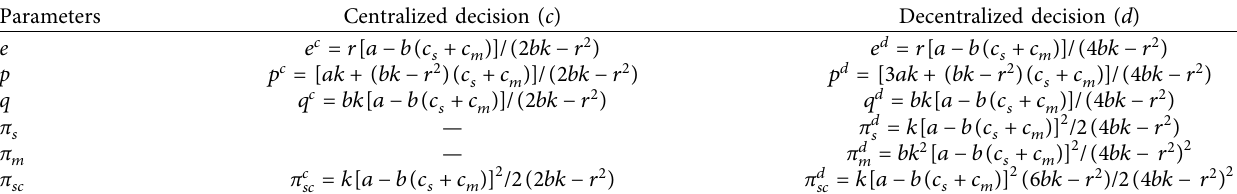
Table 2: Supply chain equilibrium results in different decision situations. Parameters Centralized decision ( c